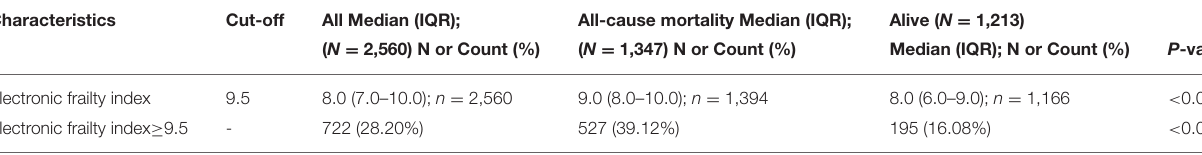
TABLE 3A | Descriptive statistics of electronic frailty index for all-cause mortality risk prediction. Characteristics